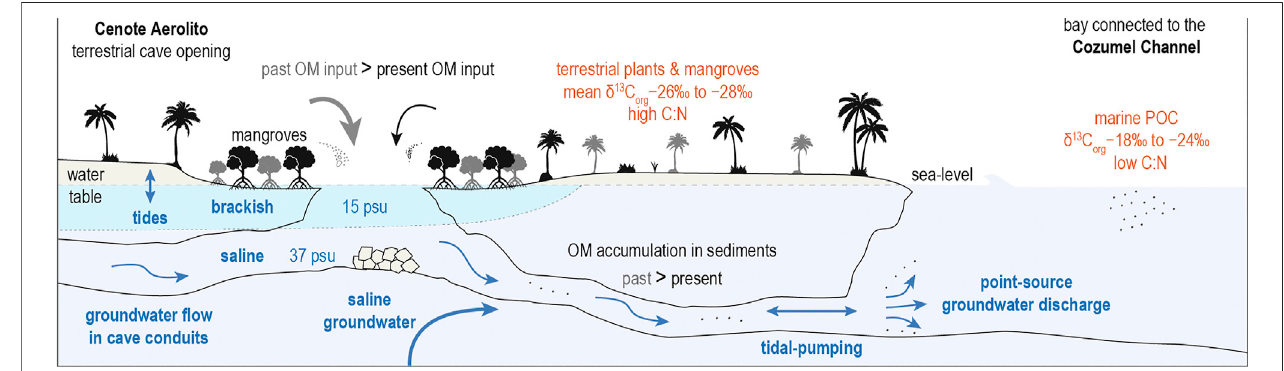
FIGURE 8 | Landscape-level conceptual model summarizing organic matter (OM) dynamics in the karst subterranean estuary (KSE). Hydrologic forcing (blue arrows) through cave conduits accelerates the transport and exchange of material between the terrestrial and marine environments. These processes are especially ampli fi ed during episodic events (e.g., hurricanes). OM inputs from mangroves and terrestrial vegetation into the KSE were greater in the past (gray arrow) than in the present (black arrow), resulting in a decrease in the accumulated OM in the caves over time. Reduced OM inputslikely caused ashift in biogeochemical conditions which prompted a change in the benthic foraminifera communities. Higher terrestrial OM accumulation near the marine opening is from persistent seaward material transport during the last